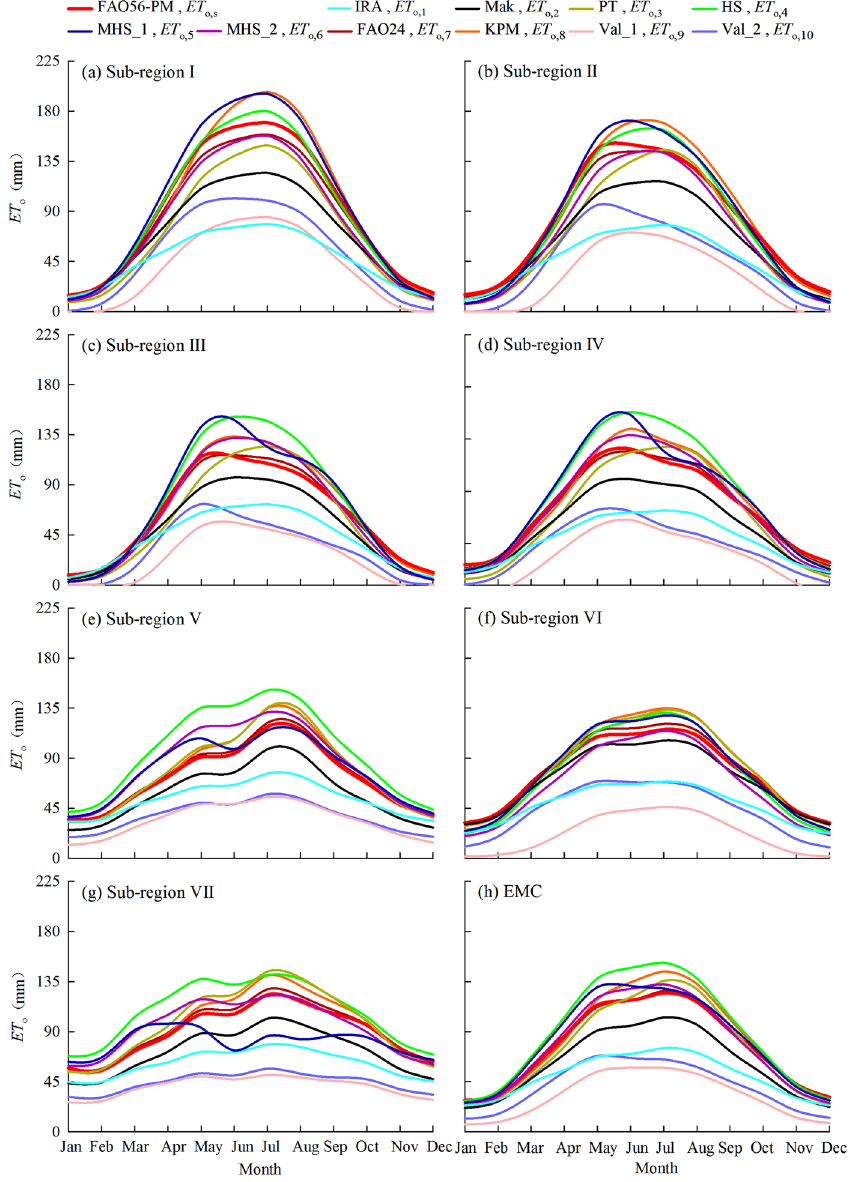
Figure 5. Temporal variations of multi-year mean monthly ET o,s and ET o,i in different sub-regions and